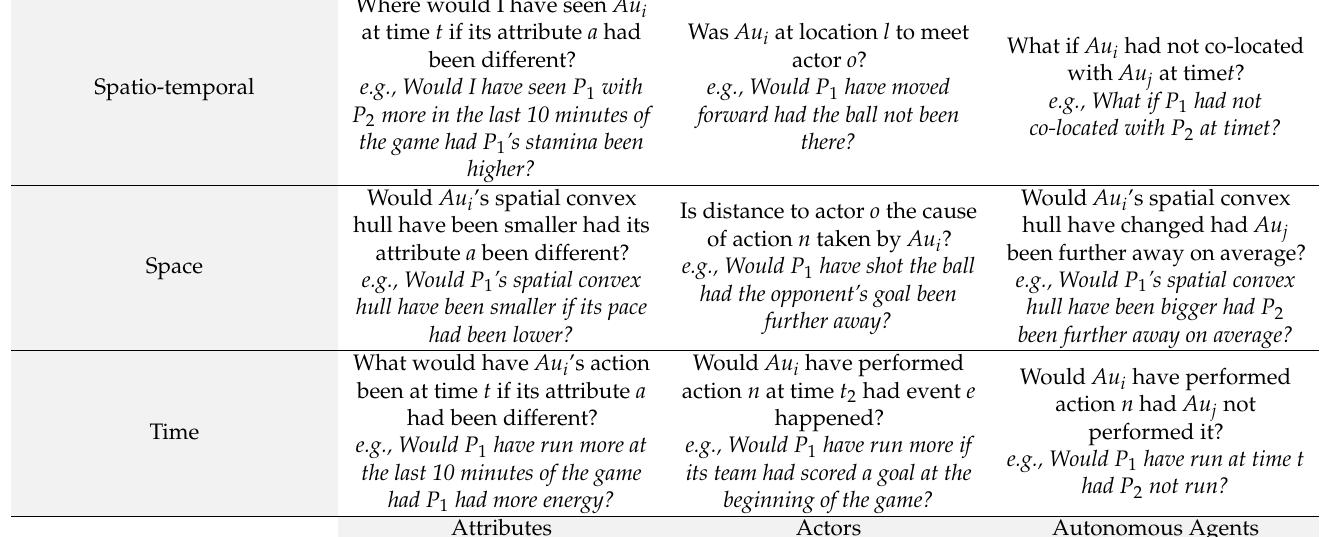
Table 3. Some typical counterfactual and why questions that can be answered by an imaginer about the auto-agents Au i and Au j (players P 1 and P 2